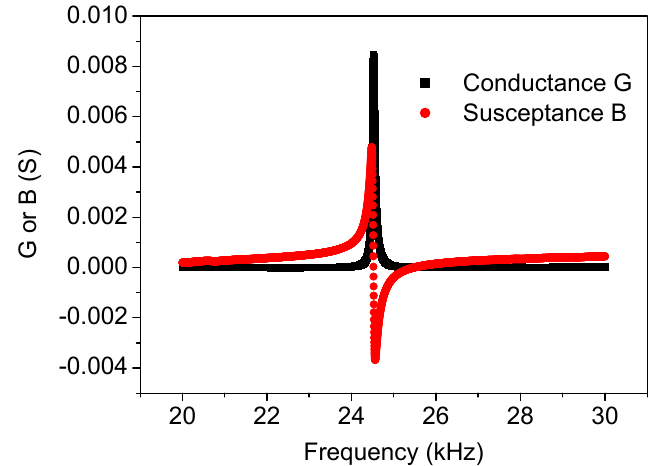
Figure 2. G ‐ B spectrum of the cutting transducer. Figure 2. G - B spectrum of the cutting